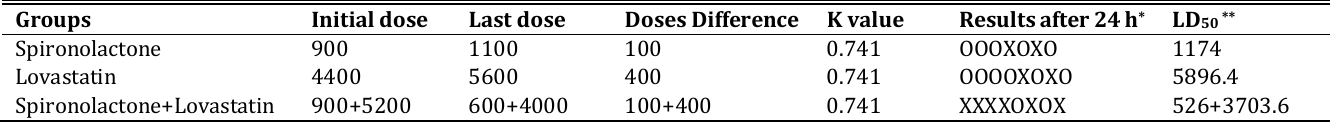
Table 2 . LD 50 of spironolactone, lovastatin and their interaction of the acute toxicity study 1 Groups